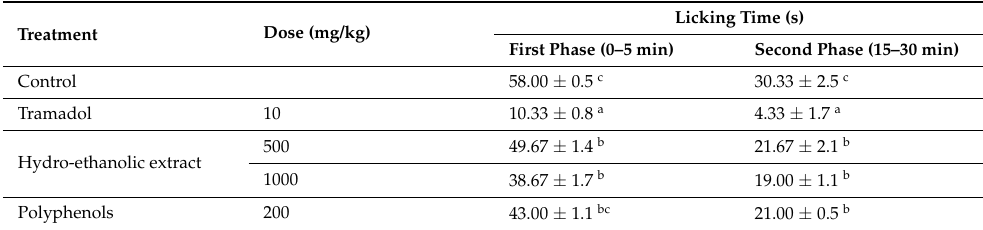
Table 7. Effect of the hydro-ethanolic and polyphenolic extracts of P. sativum Hoffm. on the response of mice upon the formalin-induced pain. Treatment